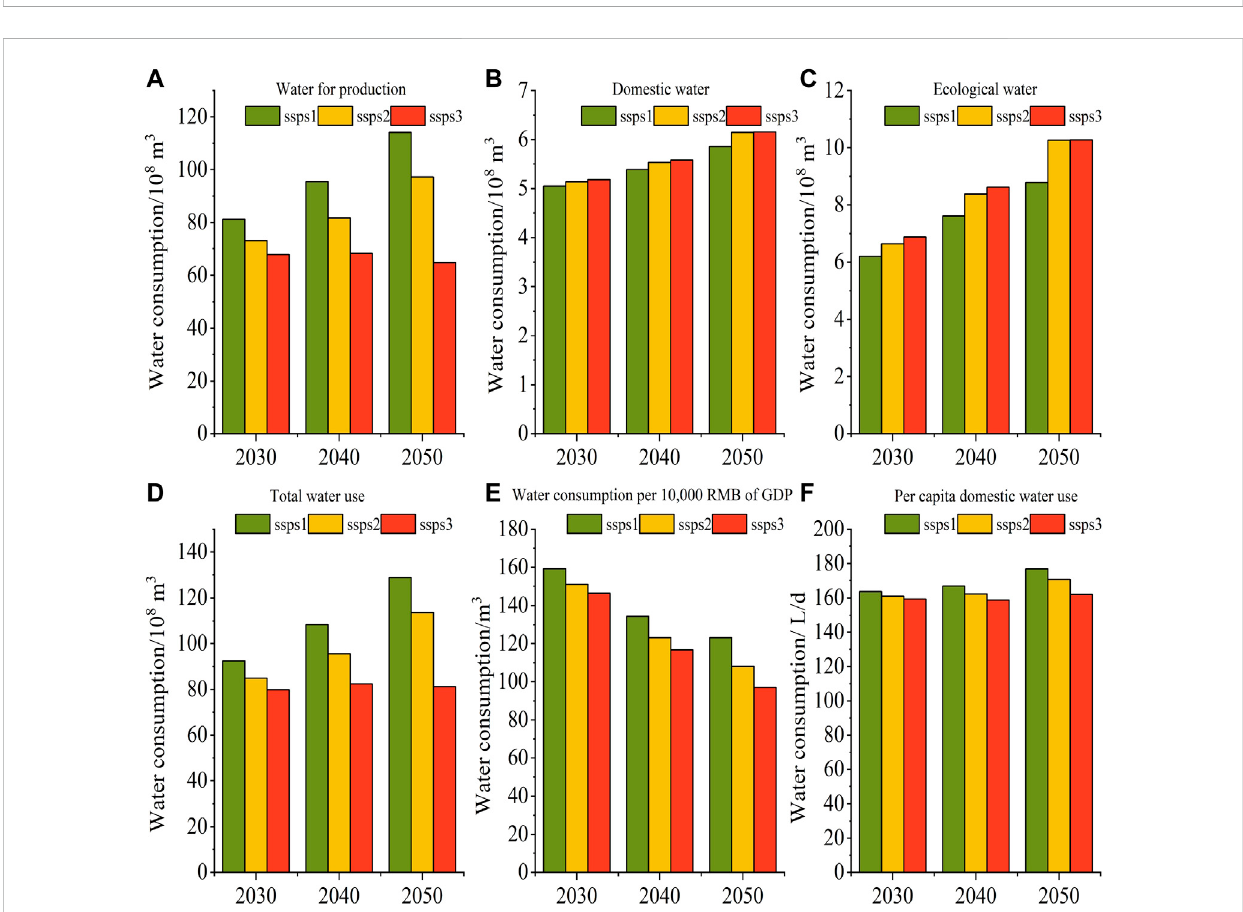
FIGURE 9 (A – D) show the total amount of production, domestic, ecological, and water consumption of the northern slopes of the Tianshan Mountains from 2030 to 2050. (E) Water consumption per 10,000 RMB of GDP. (F) Per capita domestic water